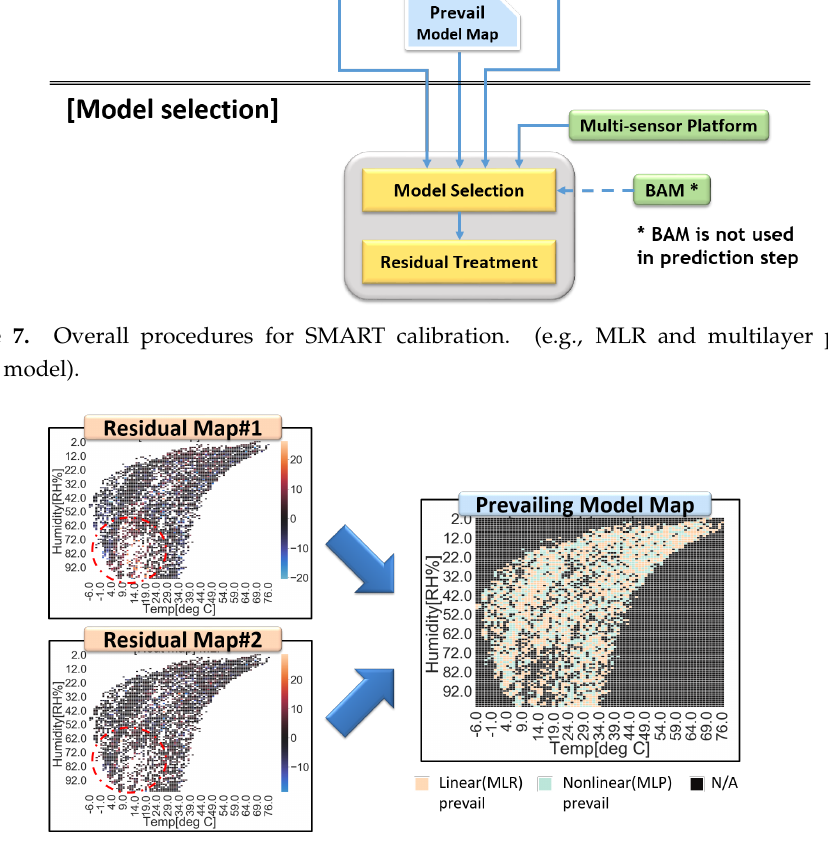
Figure 8. Residual maps and a prevailing model map for SMART calibration. Residual map#1 from the linear model ( top left ) and residual map#2 from the nonlinear model ( bottom left ) are merged into a prevailing model map ( right ). Residuals under high humidity and low-temperature condition are indicated in red dotted circles. In this region, the linear model has higher expectations of residuals than the nonlinear